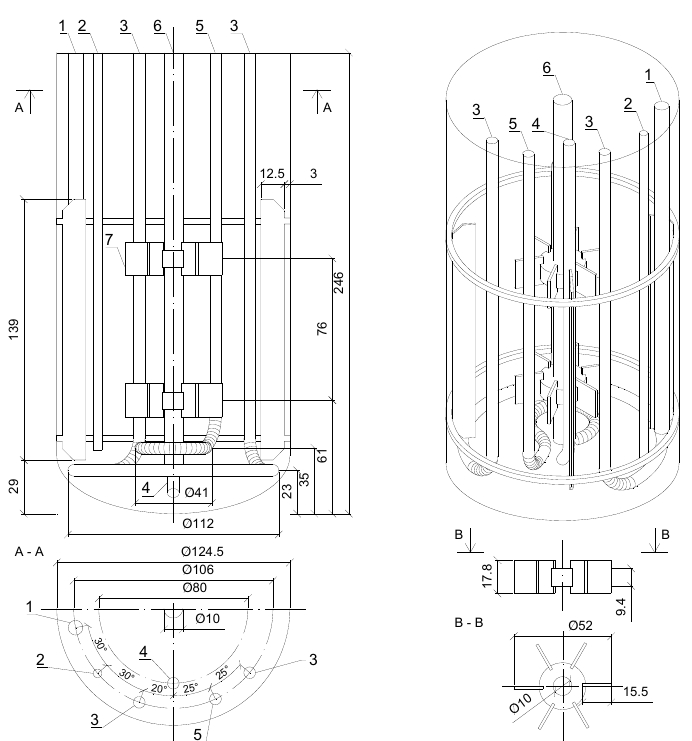
Figure 1. Sketch of BioFlo ® 115 bioreactor: 1—tube for temperature sensor; 2—sampling tube; 3—